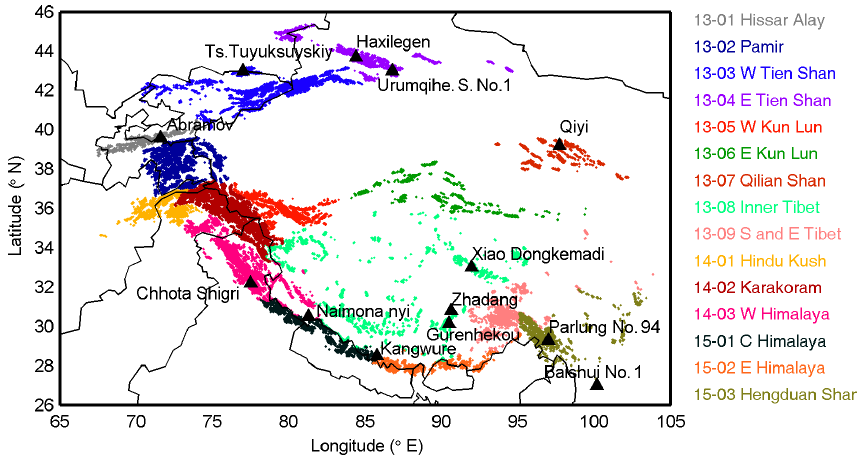
Figure 1. The HMA region analysed. Sub-regions of the HMA in RGI 5.0 are listed and colour-coded in the legend. Glaciers with SMB- versus-altitude measurements (Table 1) are marked with black